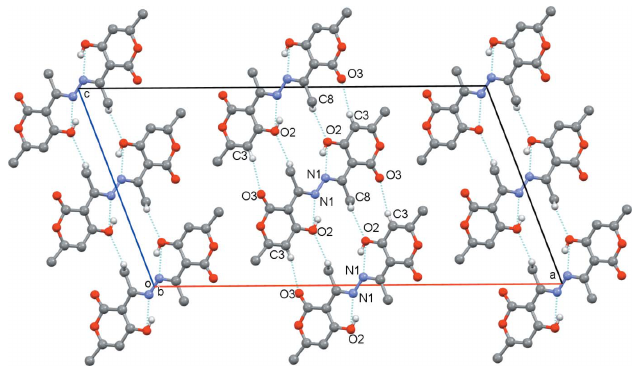
Figure 3 Crystal packing of the title compound showing molecules linked by hydrogen bonds (dashed cyan lines) and (cid:2) – (cid:2) interaction (green lines). For clarity, only H atoms involved in these interactions have been included.